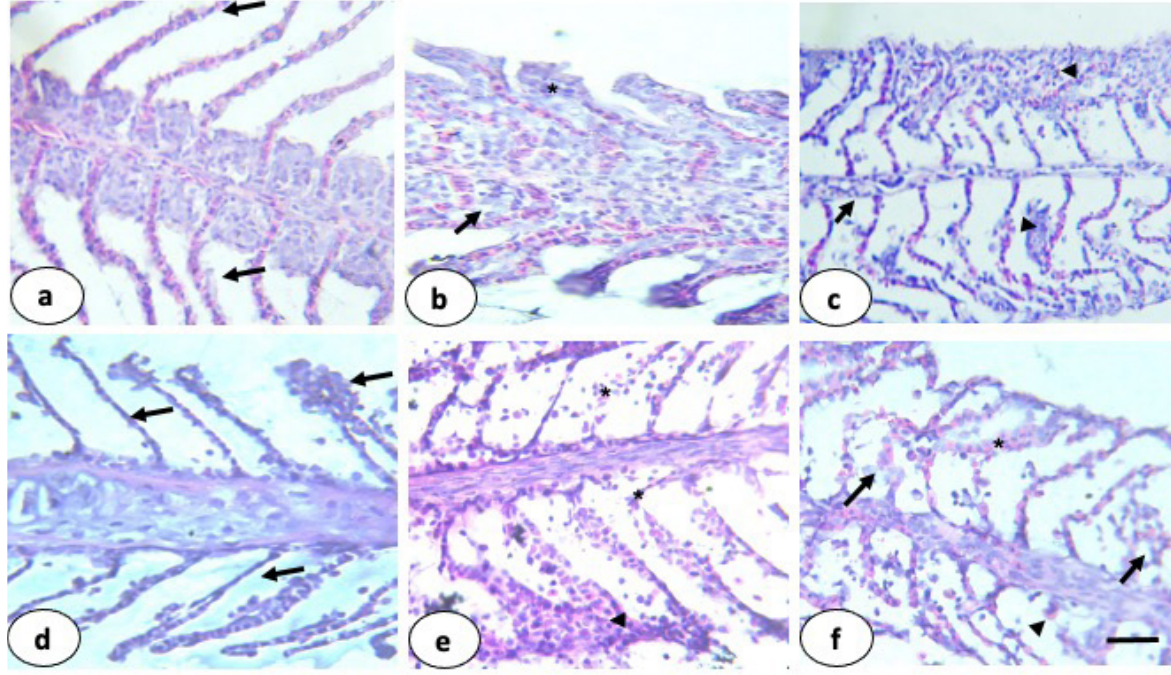
Figure 1. Gills of Piaractus mesopotamicus exposed to Serjania erecta extract. a = epithelial displacement (2.5 μg mL –1 ); b = telangiectasia, lamellar fusion (12.5 μg mL – 1 ); c = dilatation of vessels and filaments, interlamellar hyperplasia (25 μg mL –1 ); d = necrosis (50 μg L –1 ); e = hemorrhage, necrosis (100 μg mL –1 ); f = leukocyte infiltrate, hemorrhage, necrosis (150 μg mL –1 ). Hematoxylin Eosin - 400x. 10-μm